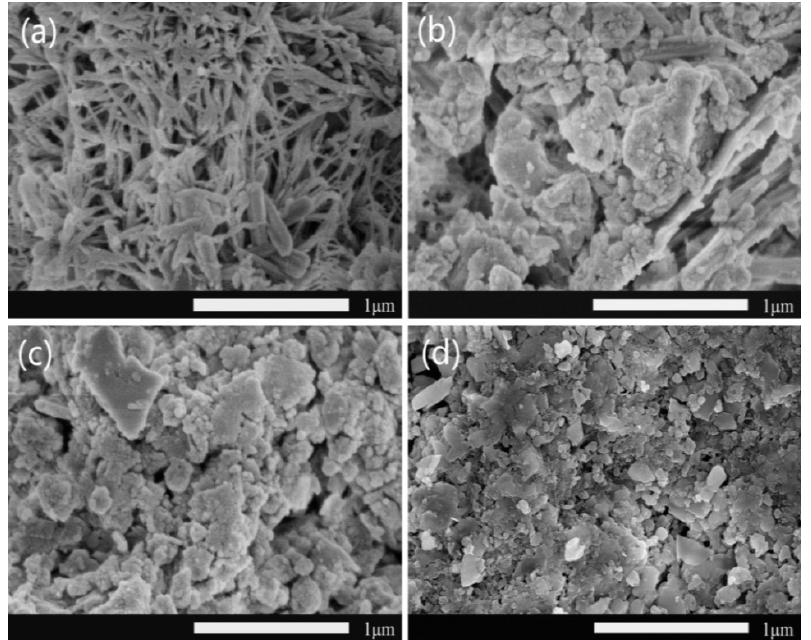
Figure 5. SEM images of cement paste with different curing ages. 1 day ( a ), 3 days ( b ), 7 days ( c ), 28 days ( d ). 28 days ( d